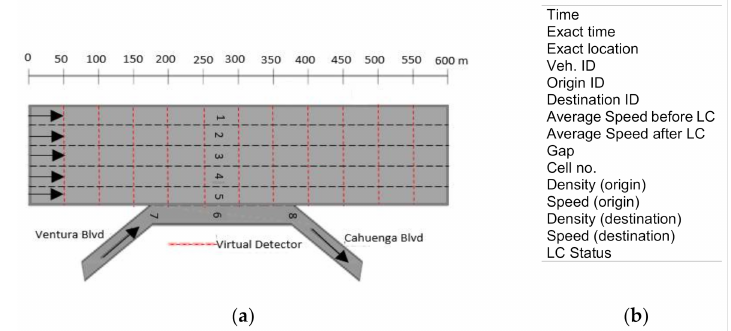
Figure 4. ( a ) US-101 Study Area, ( b ) Outputs of processed